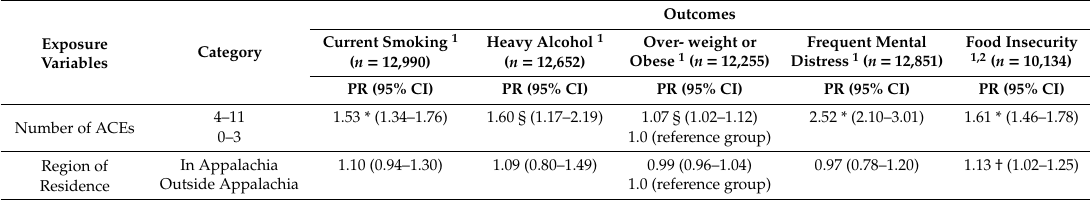
Table 4. Prevalence ratio (PR) of fair or poor health, current smoking, heavy alcohol consumption, overweight or obesity, frequent mental distress, and food insecurity among North Carolina residents, 2012 &